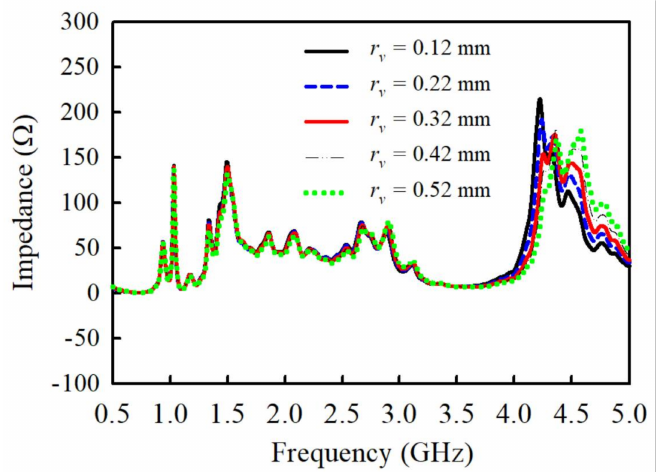
Figure 8. Simulated and measured | S 11 | of the PCD antenna with the proposed through-hole signal via (THSV) versus the conventional coaxial bead